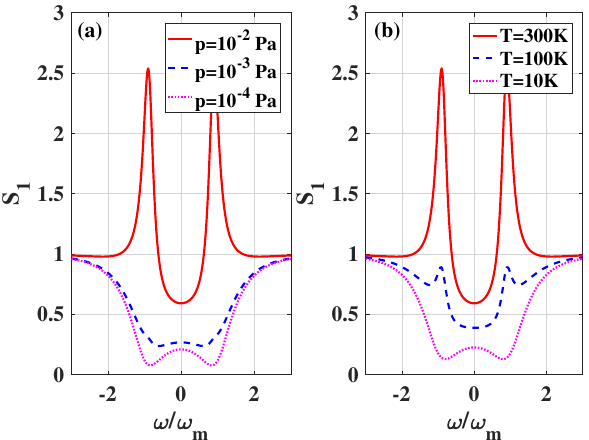
Figure 3. S 1 ( ω ) as a function of the cavity decay rate κ A . Parameters are listed as follows: optical tweezers’ power in focus P A = 0.05 W, pressure of the residual gas p = 10 − 4 Pa, temperature of the residual gas T a = 300 K, bath temperature for the torsional mode T = 300 K, and the accommodation efficient γ ac = 0.9 (see Appendix C). Other parameters are the same as Figure 2.